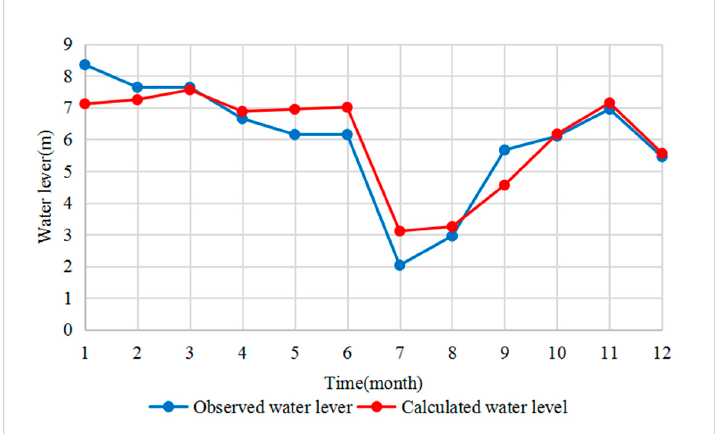
Figure 6. Measured flow field map of the research area in 2017.